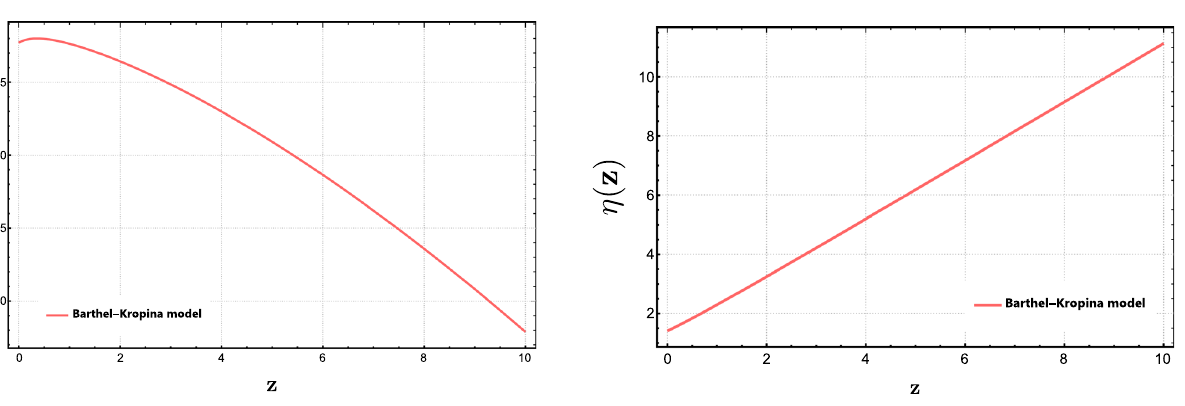
Fig. 13 The evolution of the physical pressure p DEphy in the Barthel– Kropina dark energy model as a function of the redshift z